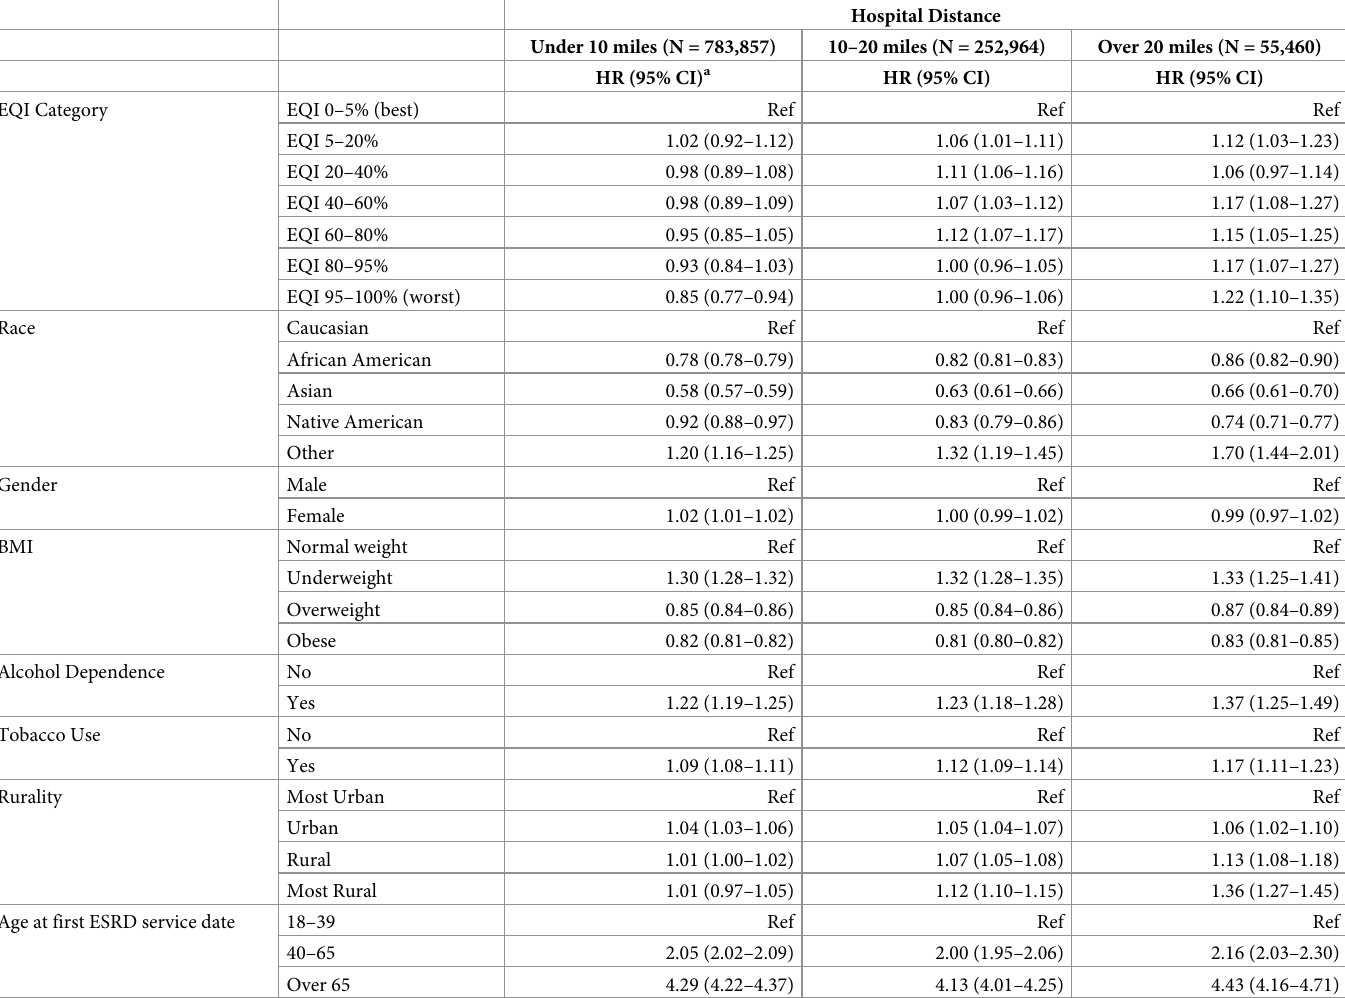
Table 3. Hazard ratios for ESRD and total EQI stratified by distance to the nearest hospital (1,092,281 patients,